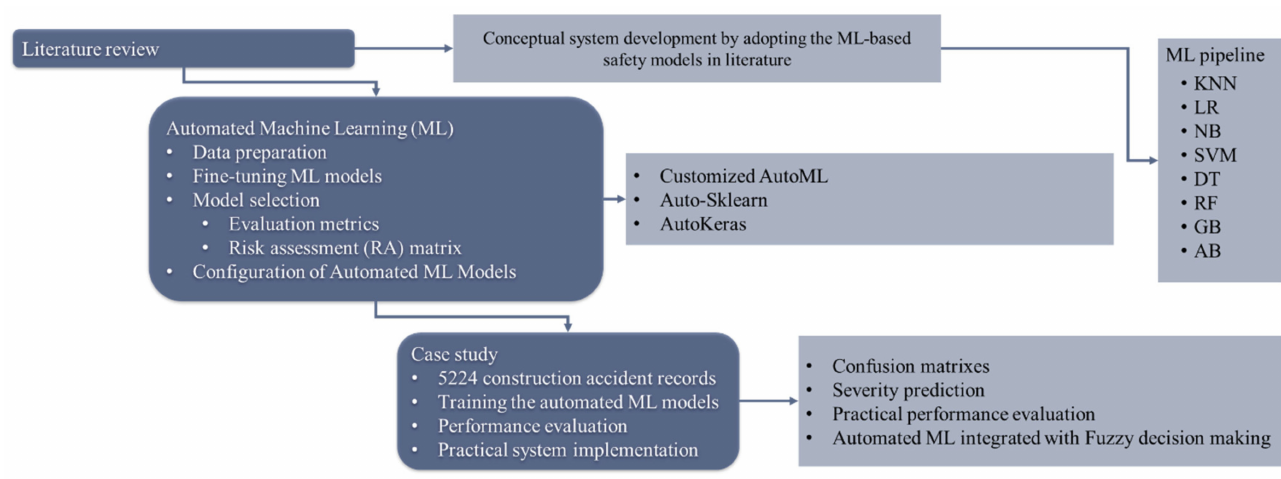
Figure 1. Outline of this